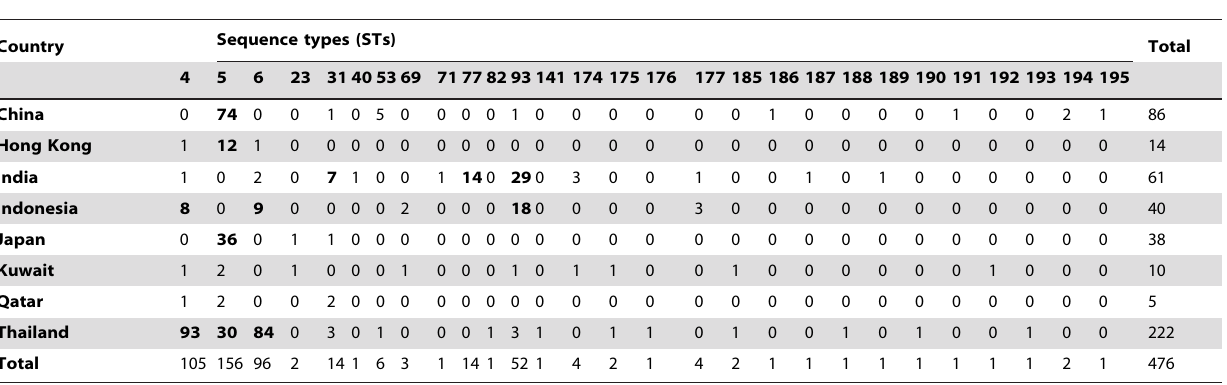
Table 2. Distribution of sequence types (STs) of C . neoformans var. grubii isolates among different countries.